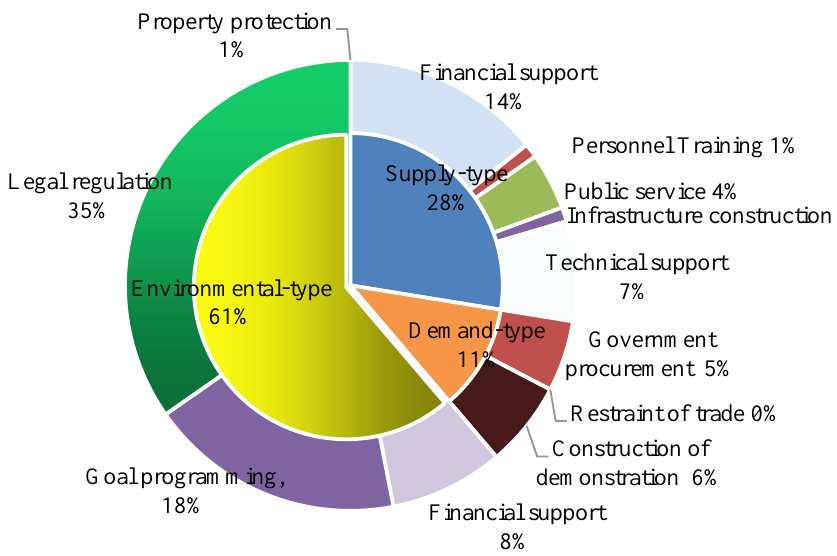
Figure 1. Double-ring diagram of the proportion of policy tools and sub-tools.